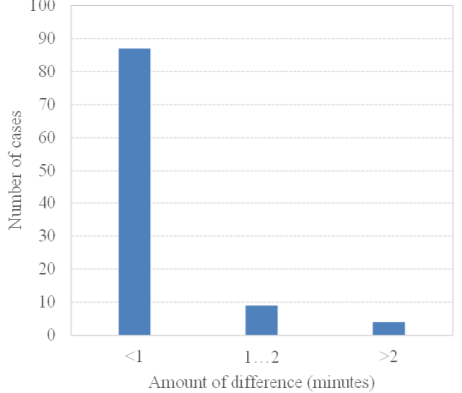
Figure 10. Comparison of the simulated and predicted times. Energies 2016 , 9 , 1090 12 of 16